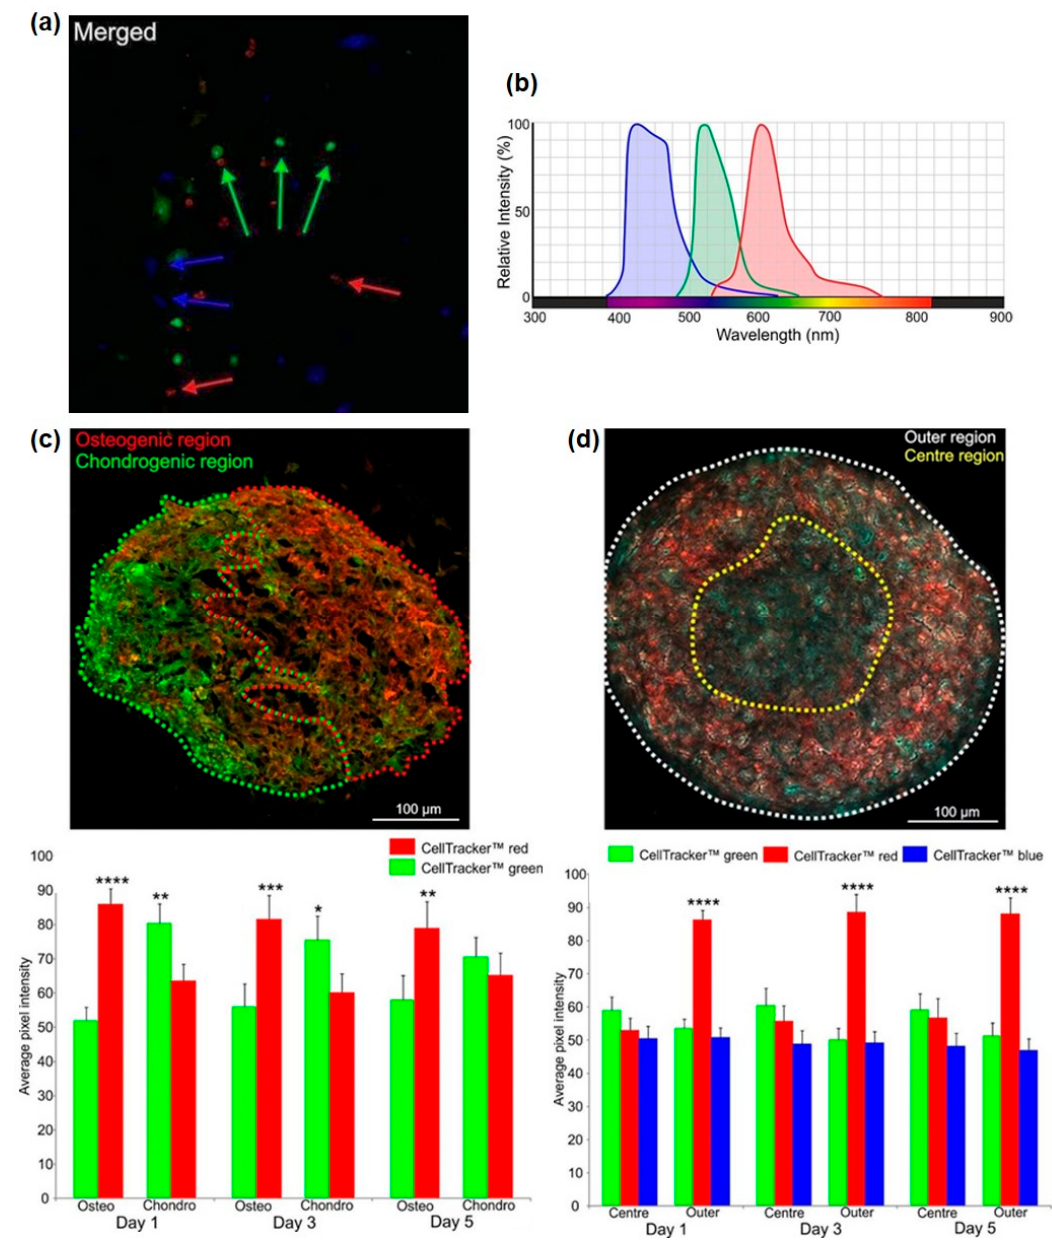
Figure 5. Analysis of OC and OCE spheroid self-organisation. ( a ) CellTracker™ red, green and blue cell labelling in 2D tri-culture to identify the different cell types: osteogenic MSCs (red), chondrogenic MSCs (green) and ECs (blue), arrows indicate selected red, green and blue cells. ( b ) Spectral analysis of the three different CellTracker™ colours showing peak emission wavelengths. ( c ) Day 1 OC section separated into either osteogenic or chondrogenic regions using red or green dotted line. Graph below shows the analysis of spheroid sections at Days 1, 3 and 5 quantifying presence of CellTracker™ red or green within either the osteogenic or chondrogenic regions. ( d ) Day 1 OCE spheroid section separated into either a core region (yellow dotted line) or outer region (white dotted line) based on colour distribution. Graph below shows the analysis of spheroid sections at Days 1, 3 and 5 quantifying presence of CellTracker™ red, green or blue within either the centre or outer regions.